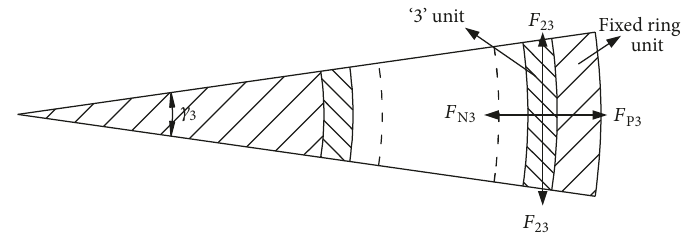
Figure 9: Cross-section of one unit of part